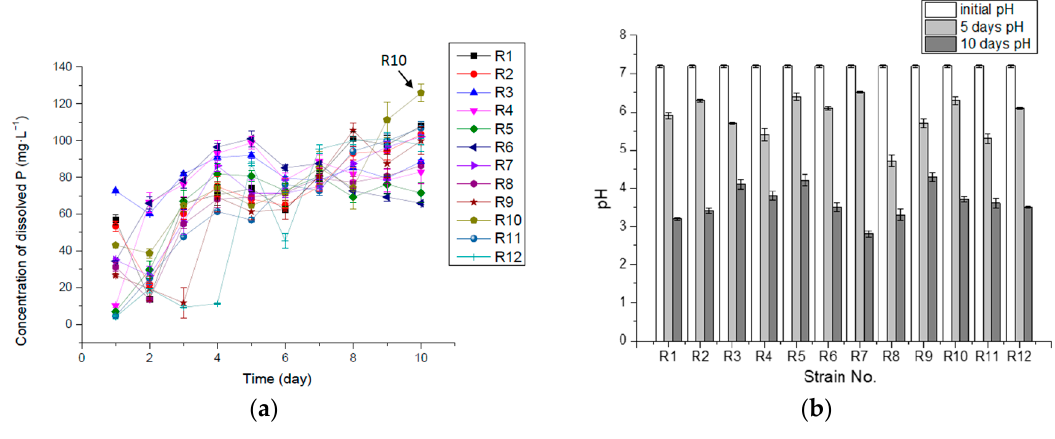
Figure 2. Concentration of dissolved P ( mg·L − 1 ) ( a ) and pH ( b ) in 10-day incubation in liquid medium with insoluble Ca 3 (PO 4 ) 2 . Table 1. Maximum concentration and rate of P release in 10-day incubation in liquid medium with insoluble Ca 3 (PO 4 ) 2 .